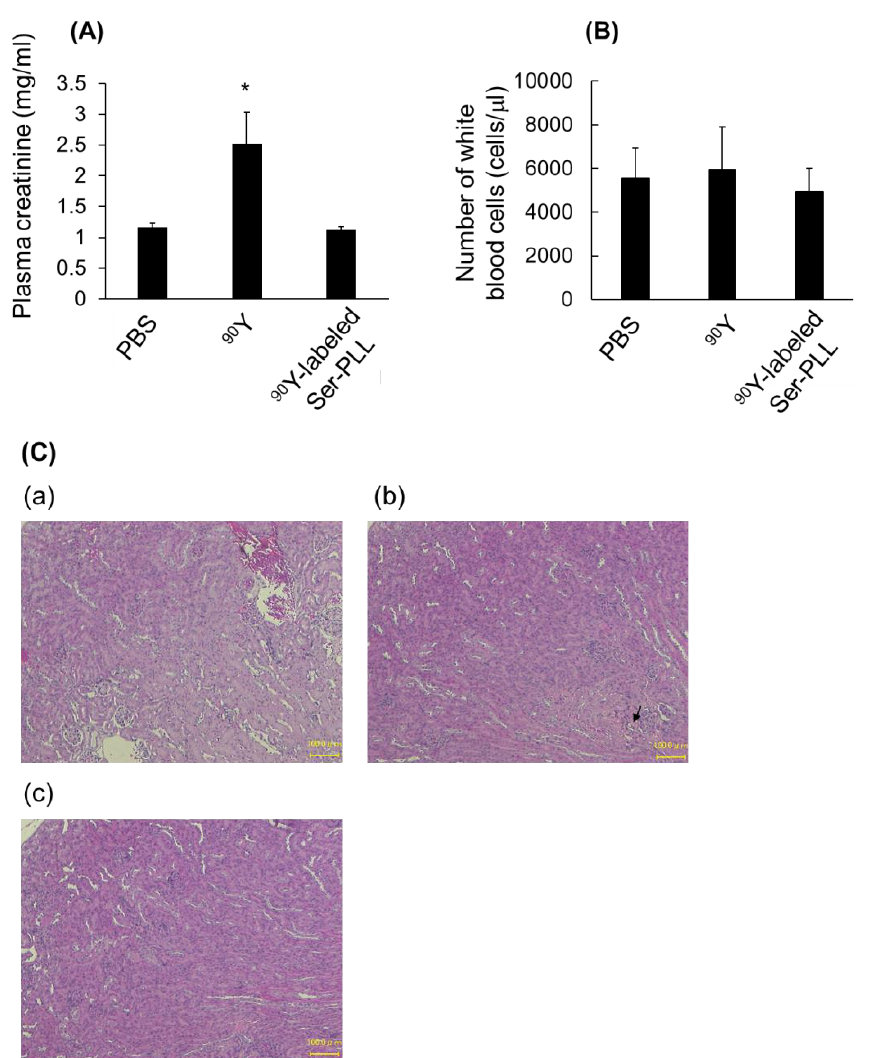
Figure 7. Plasma creatinine ( A ) and white blood cell counts ( B ) after intravenous injection of 90 Y-labeled Ser-poly-L-lysine (Ser-PLL) at 0.3 MBq/mouse into mice inoculated with Colon26/Luc cells in right kidney cortex. ( C ) Histological examination of left kidneys of mice injected with 90 Y-labeled Ser-poly-L-lysine (Ser-PLL) at 0.3 MBq/mouse and inoculated with Colon26/Luc cells in right kidney cortex. PBS ( a ), free 90 Y ( b ), 90 Y-labeled Ser-poly-L-lysine (Ser-PLL) ( c ). (scale bar = 100 μm) Mice were sacrificed 14 d after tumor induction. Data are means ± SE of ≥ three mice. * statistically significant difference compared with PBS group ( p < 0.05).